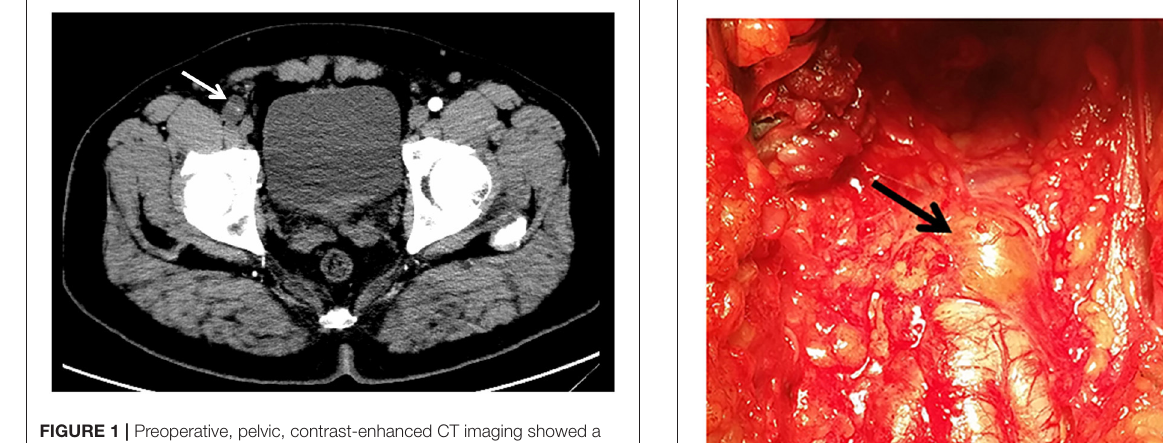
the arterial intima was intact, and the vessel wall was locally thickened. A pectin-like material filled the space between the layers of vessel adventitia, causing luminal stenosis ( Figure 3